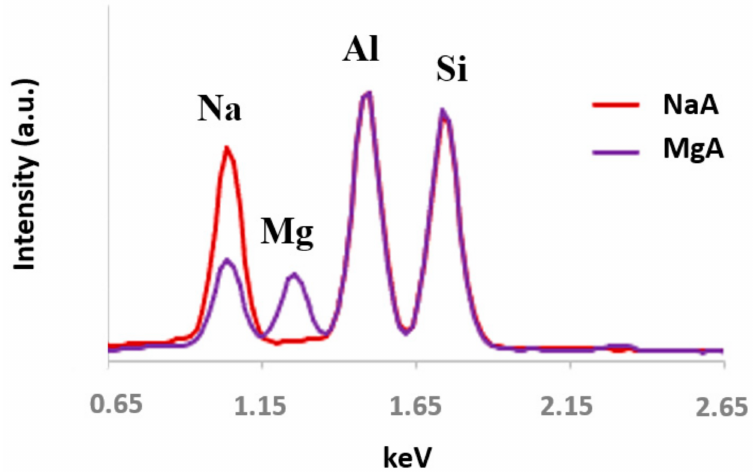
Figure A1. EDX spectra of NaA and MgA samples.